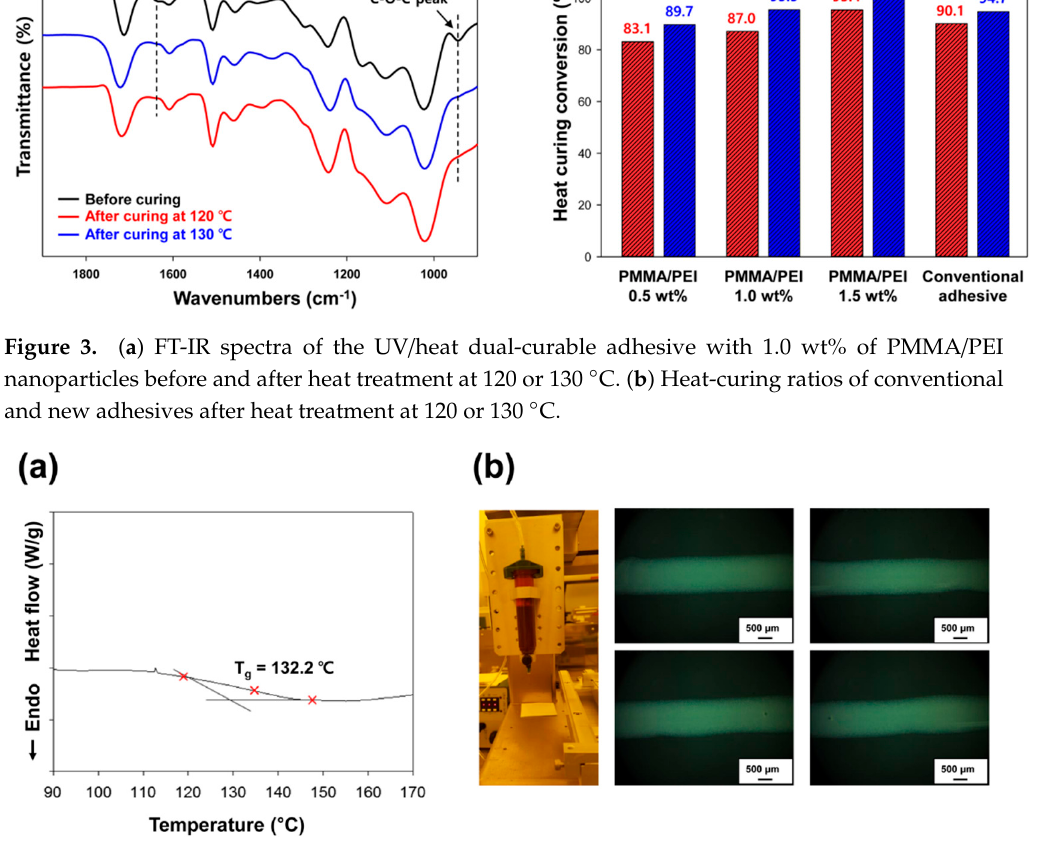
Figure 4. ( a ) DSC thermogram of the adhesive containing 1.5 wt% of PMMA / PEI nanoparticles. ( b ) Optical images of adhesive lines after drawing and sandwiching the adhesive between two glass substrates using a commercial seal dispenser.